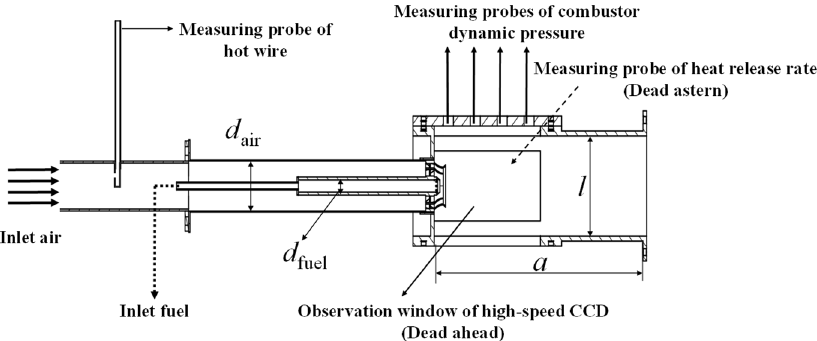
Figure 1. The structure and measurement layout of the M combustor.